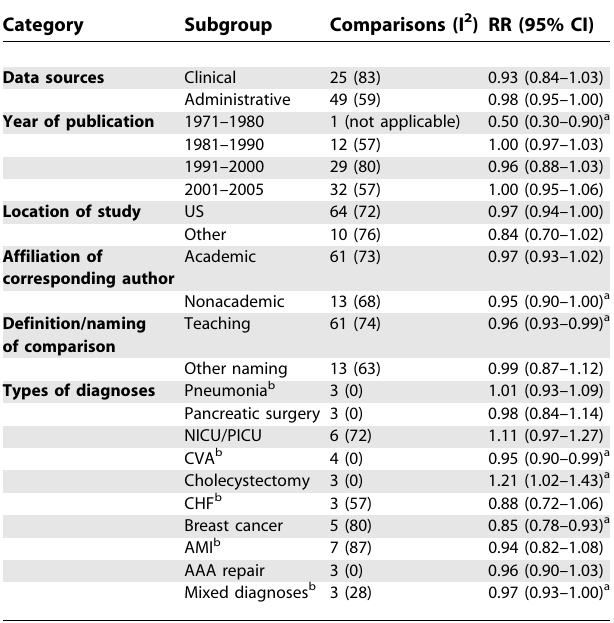
Table 4. Subgroup Analyses for